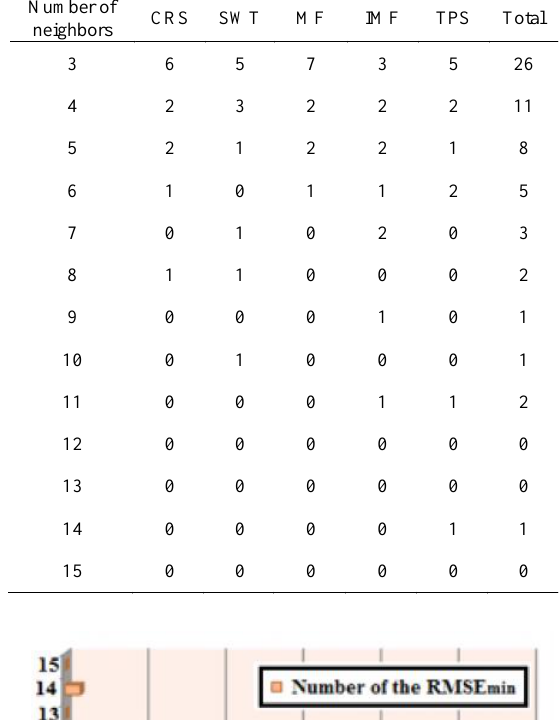
versus five functions: CRS, SWT, MF, IMF, and TPS and the number of neighbors from min 3 to 15